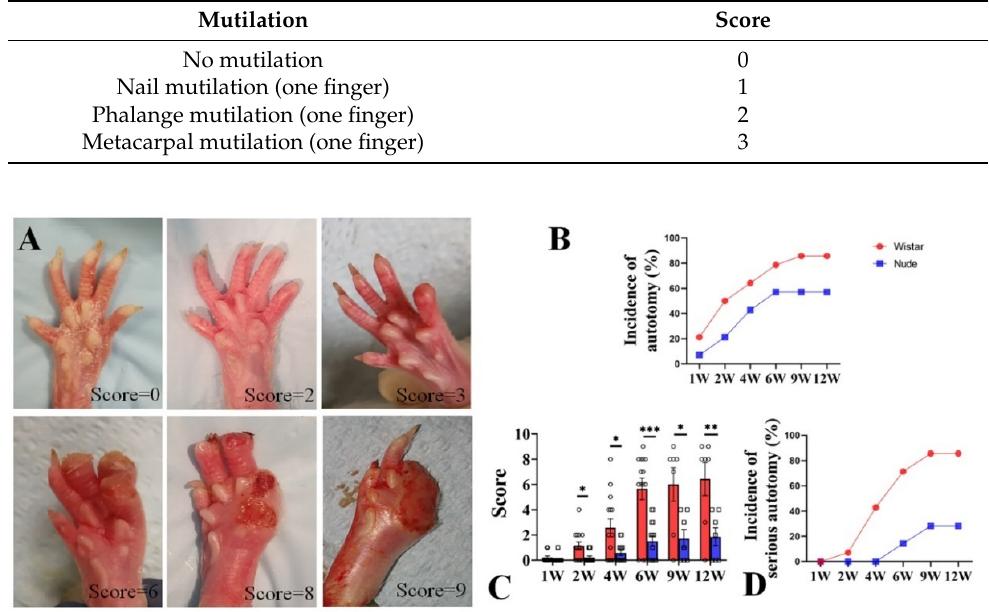
Figure 1. Autotomy in nude and Wistar rats. ( A ). Representative photographs and Wall’s scores of autotomy in the rat after peripheral nerve injury. ( B ). The incidence of autotomy in Wistar rats was higher at different weeks than in nude rats. ( C ). The Wall’s scores of autotomy in Wistar rats were significantly higher than those of nude rats both at different weeks. ( D ). More serious-type autotomy in Wistar rats was observed compared to nude rats. Student’s t -test in C. Sample size (n): n = 14 at 1, 2, 4, and 6 weeks and n = 7 at 9 and 12 weeks. * p < 0.05, ** p < 0.01, *** p < 0.001; Wistar rats vs. nude rats.